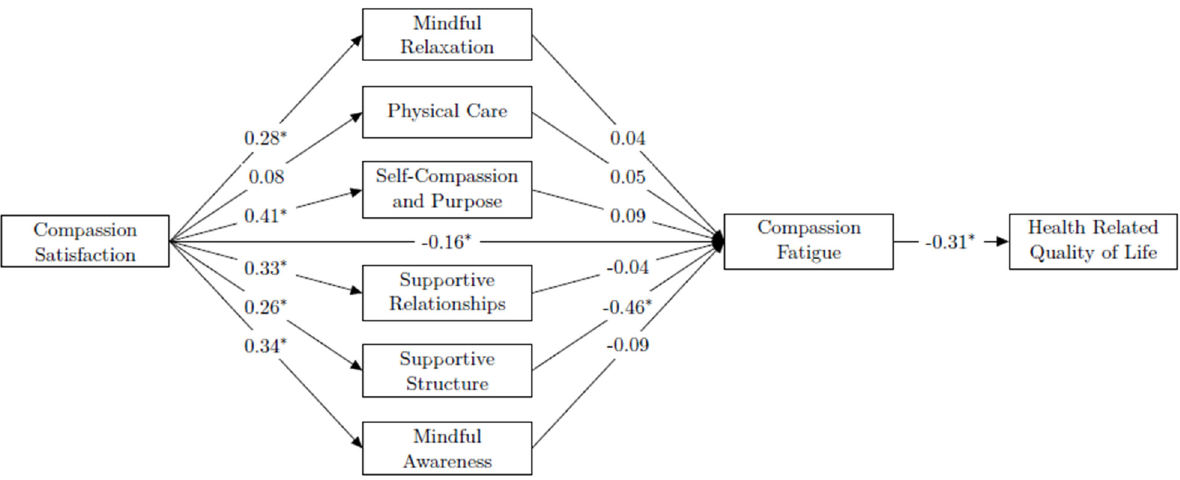
Figure 4. Model 2. This figure shows the level of significance at the p < 0.05 level for the variables connected with the one-way arrow for those noted with an asterisk (*).